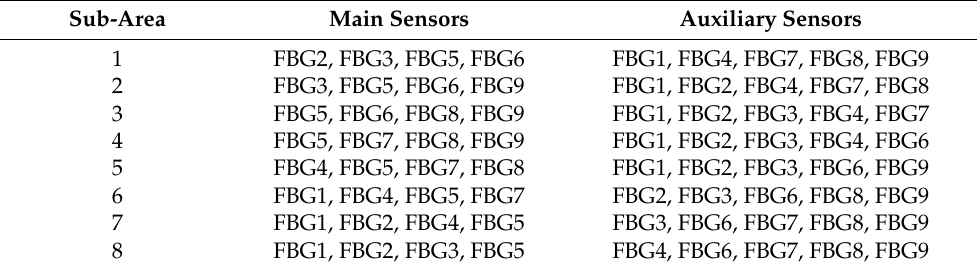
Table 2. Sub-areas and sensor